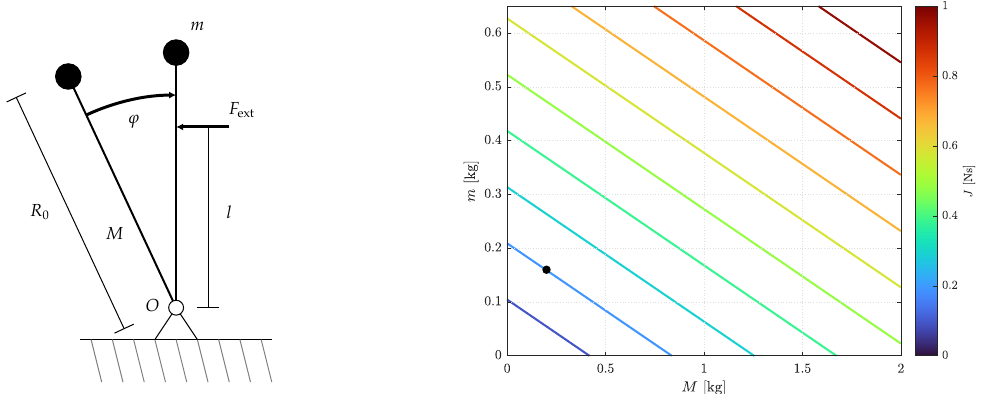
Figure 2. ( Left ) The scenario considered for investigating the safety aspect is a one degree of freedom manipulator of mass M , with a payload of mass m attached to its tip. The mass of the link is assumed to be concentrated as a point mass at the middle of the link. The radius of the link (measured from pivot point O to the tip) is R 0 . The robot collides with a human at a distance l from the pivot point, causing a resulting external force F ext acting on the movable link and similarly acting on the human. The influence of gravity is not considered in this example. ( Right ) The momentum J (time integral over external force) as a function of the robot arm mass, M , and the payload mass, m . The black dot indicates the mass of the robot arm presented in this work ( M = 0.2kg) and a payload mass of m = 0.16kg as used in the applications presented in the last part of this work. The distance from pivot point to collision point, l , is assumed to be two-thirds of the link radius. The initial angular velocity of the robot arm is 1.8rad/s corresponding to the highest angular velocity considered in this article. The momentum grows with the robot link mass and the payload mass. If we want to keep the momentum constant (moving on a colored line) and the mass of the robot arm is increased by a factor of two, the payload mass would need to be reduced by one